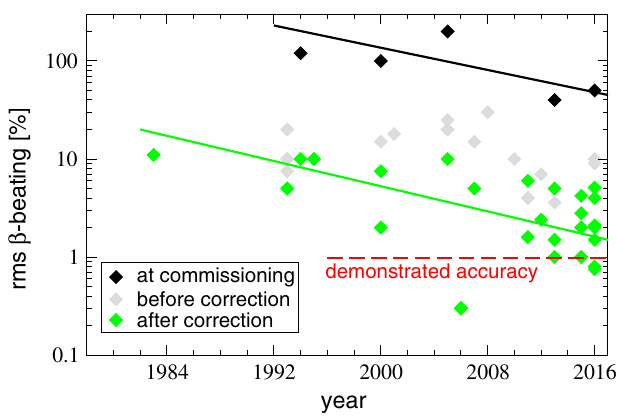
FIG. 1. Measured or inferred β -beating versus time for many circular accelerators as found in the bibliography of this paper. Three stages are differentiated: (i) commissioning, when magnet powering mistakes are expected, (ii) after fixing these mistakes but before careful optics corrections and (iii) after final optics corrections.